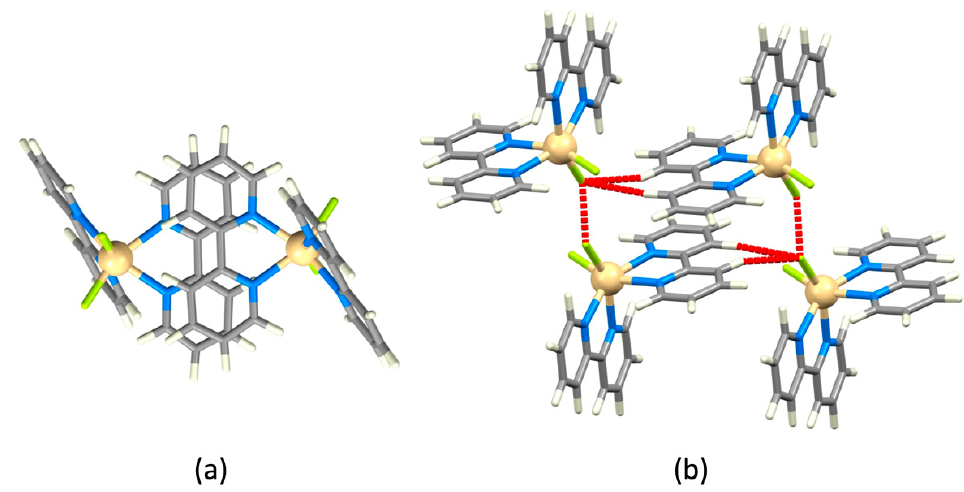
Figure 11. ( a ) One of two crystallographically independent centrosymmetric bpy...bpy π -stacking motifs in cis- [Cd(bpy) 2 F 2 ] · 3.5H 2 O (CSD refcode YAYMET) [6]. ( b ) The bpy H3 and H3 ′ atoms in the motif shown in ( a ) form CH...F interactions with adjacent molecules; H...F and F...F contacts are shown in red. In the second crystallographically independent motif of this type, only one H...F distance is short enough to be considered (see Table 7). Table 7. Metric parameters for CH...F short contacts in cis- [Cd(bpy) 2 F 2 ] (Figure 6) involving bpy H3 and H3 ′ atoms (see Figure 8b). There are two crystallographically independent but similar motifs.